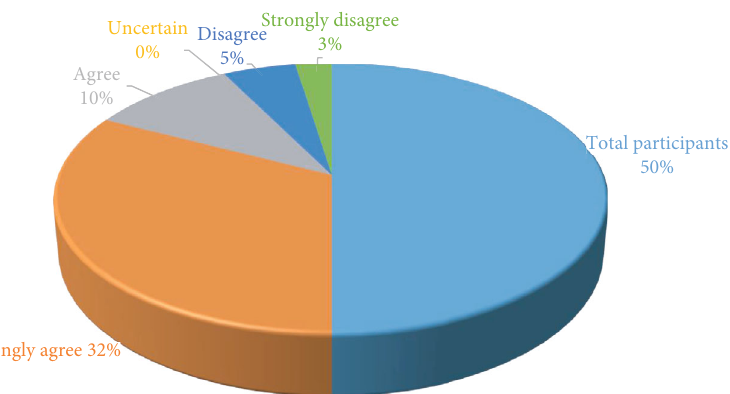
Figure 20: Issues in terms of the existing system.